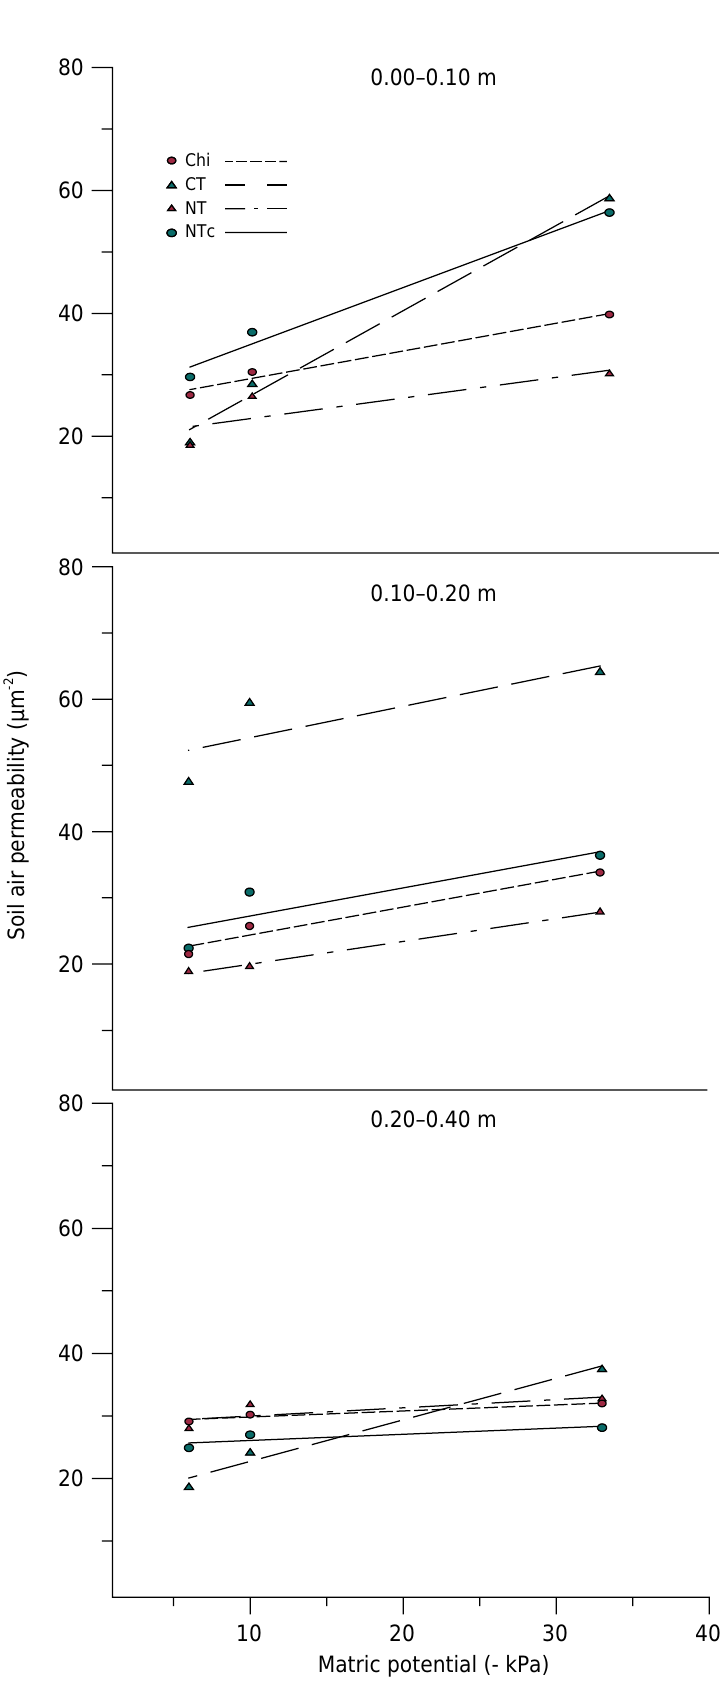
Figure 7. Soil air permeability (Ka, μm 2 ) at matric potentials (0, -6, -10, and -33 kPa) for chisel plough (Chi), conventional tillage (CT), no-tillage (NT), and compacted no-tillage (NT C ), in three soil layers at physiological maturity of the cassava